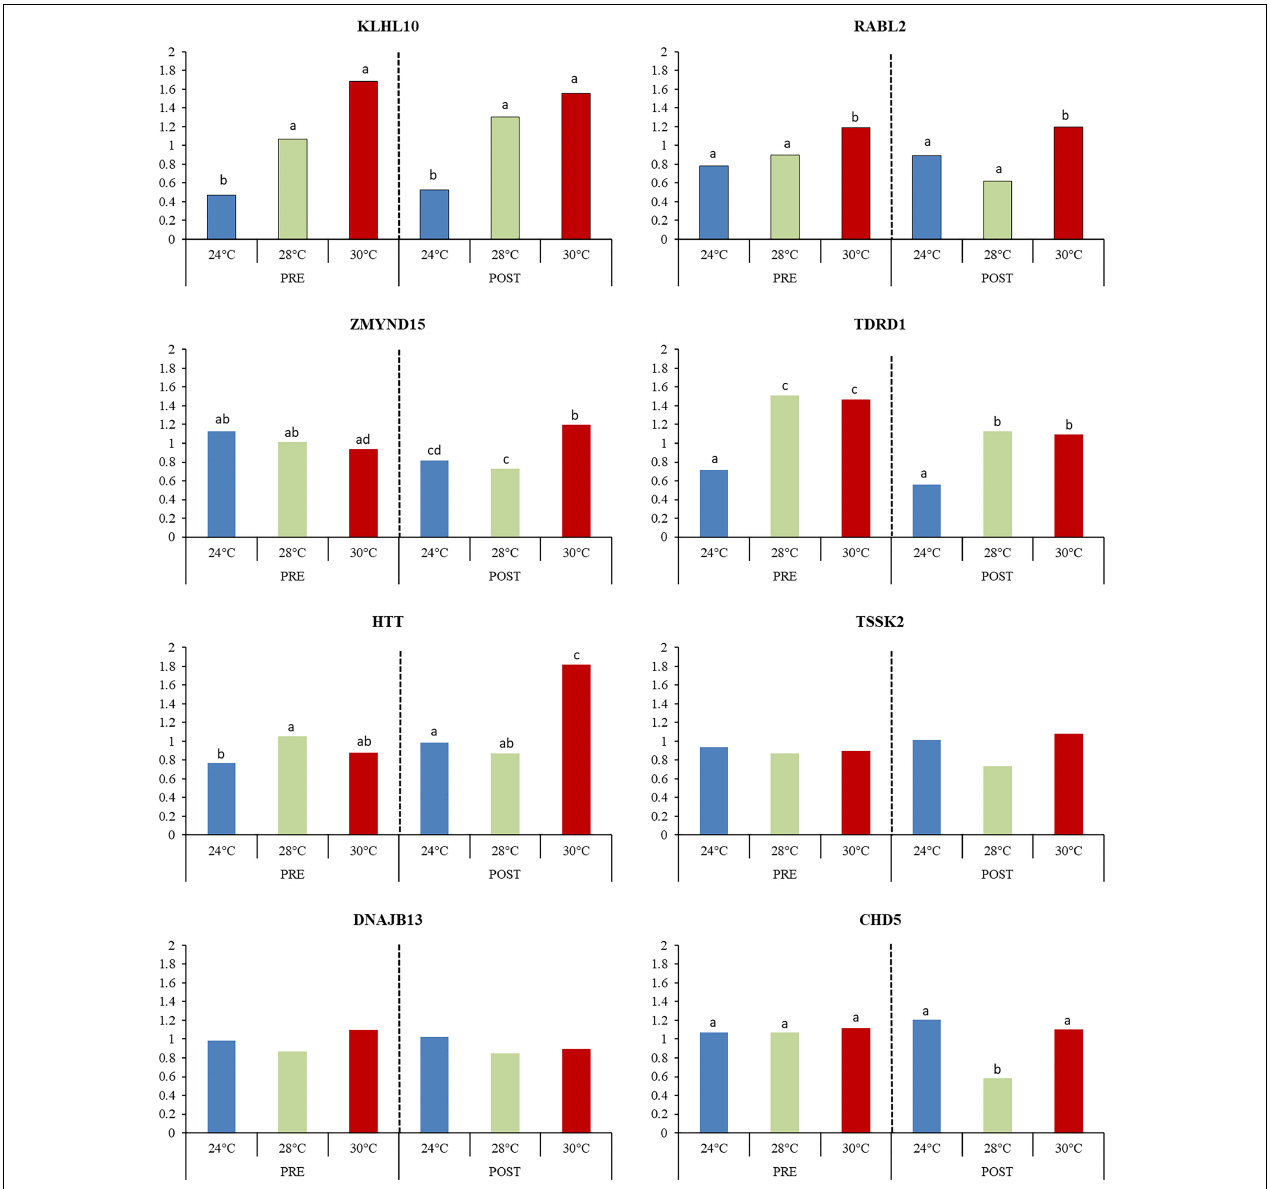
FIGURE 10 | Relative expression of transcripts associated with male reproductive process. Mean values (back-transformed from logarithms) are shown in bars and letters are used to denote differences between means ( P <